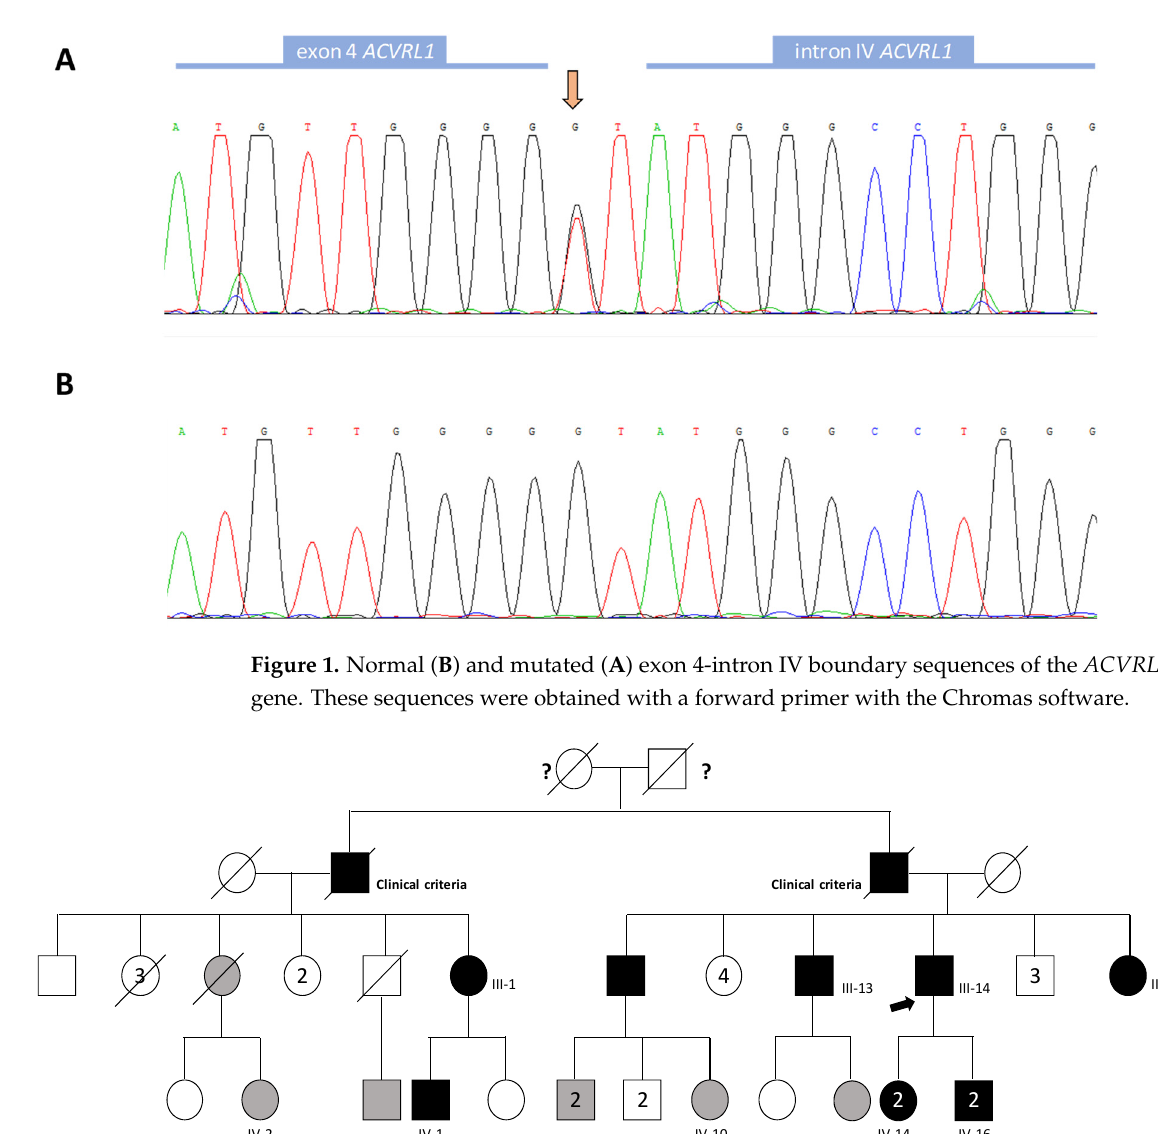
Female with symptoms(untested) Malewith Figure 2. Pedigree of the affected family. In black, individuals with reported HHT (positive for mutation), in open, individuals with no HHT symptoms (negative for mutation) and in grey individuals with HHT clinical symptoms but untested. The black arrow indicates the proband. Numbers inside the symbols indicates the number of siblings with same phenotype. ( I – IV indicate the family